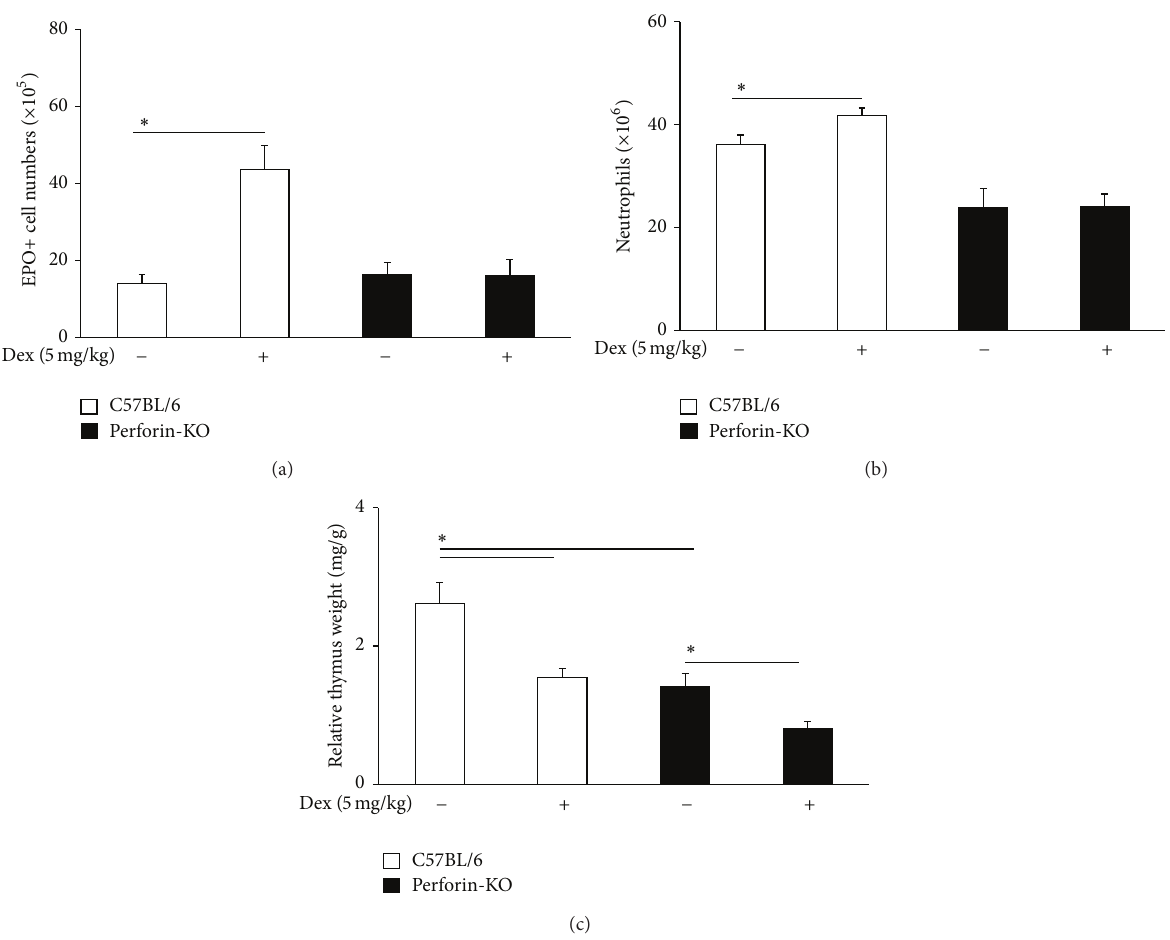
Figure 4: In vivo granulopoietic response to dexamethasone injection in B6 and Pfp mice ((a), (b)). Data are Mean + SEM of the numbers of EPO+ cells (a) and neutrophils (b) in freshly harvested bone-marrow of age-matched (12 weeks) B6 (white bars) or Pfp (black bars) mice, 24 h after i.p. injection of dexamethasone (Dex, 5 mg/kg) or saline. For B6 and Pfp mice, 𝑛 = 3 and 𝑛 = 5 , respectively. (c) Data are Mean + SEM of the relative weight of the thymus (mg/g body weight) from age-matched B6 (white bars) or Pfp (black bars) mice, 24 h after injection of dexamethasone or saline as above. For B6 and Pfp mice, 𝑛 = 4 and 𝑛 = 5 , respectively. ∗ Significant differences relative to the indicated